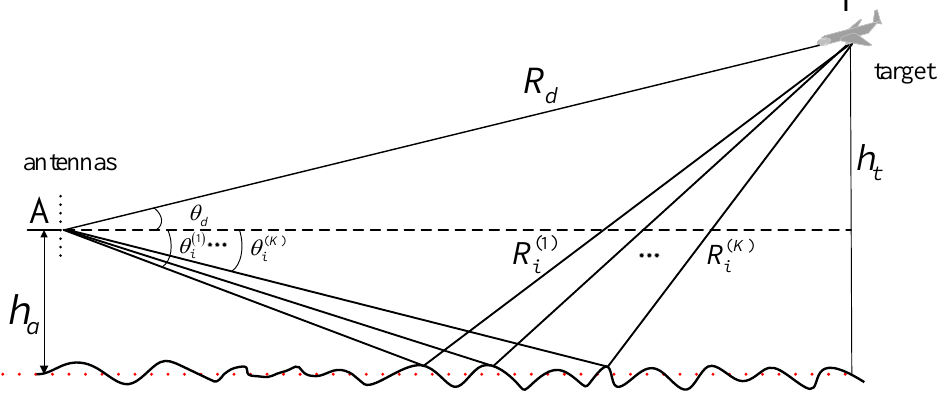
Figure 1. Multipath propagation geometry for VHF radar over complex